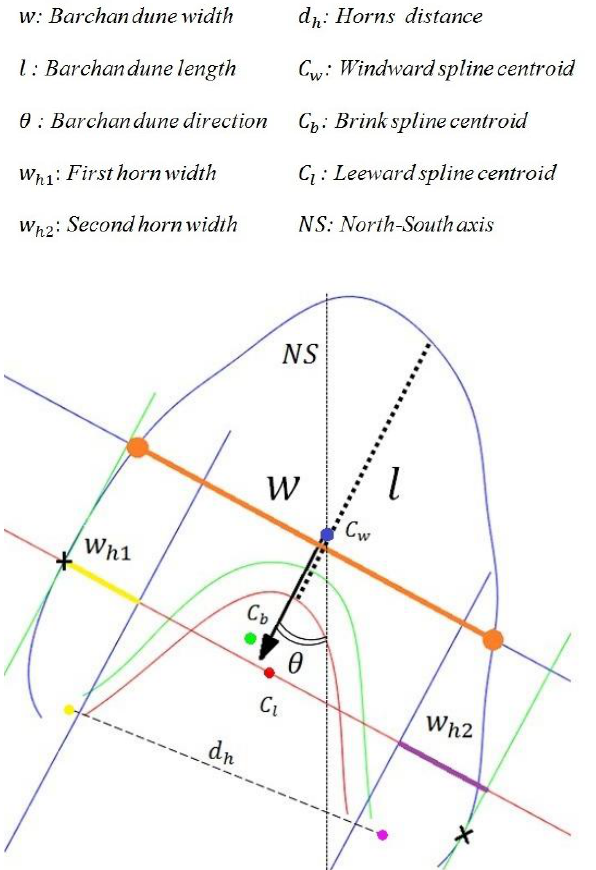
Figure 3: 2D barchans dune allometric